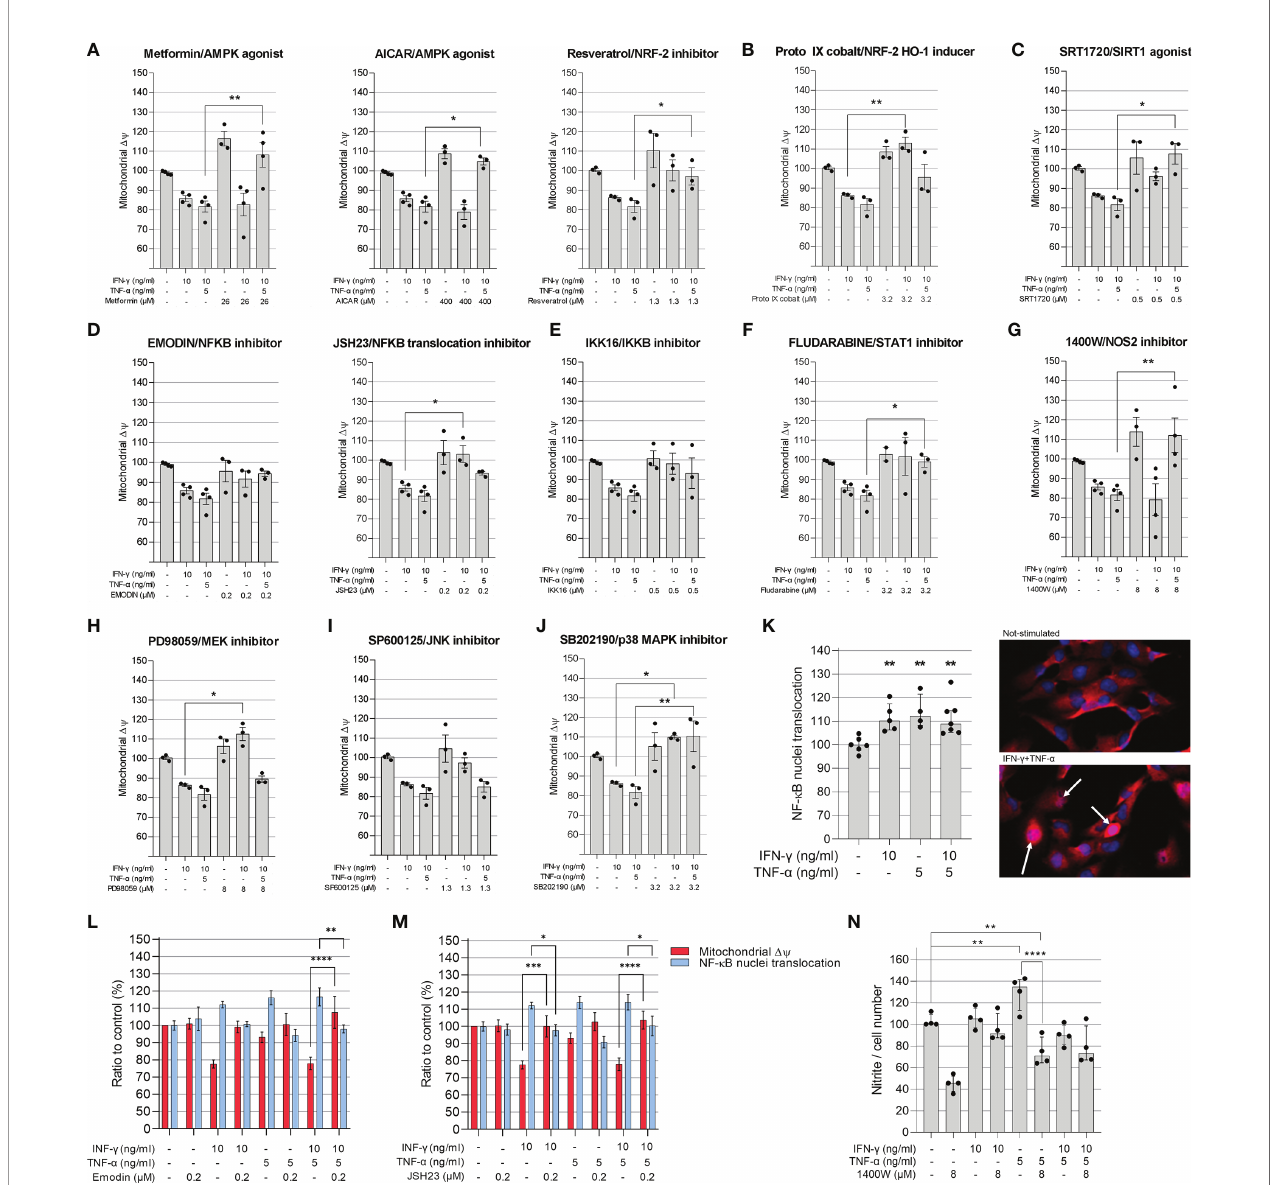
FIGURE 4 | Evaluation of compounds in the mitochondrial membrane potential of AC-16 cells. Selected doses of agonists of AMPK (A) , NRF2 (B) , SIRT1 (C) or inhibitors of NF- k B (D) , IKK b (E) , STAT1 (F) , NOS2 (G) , MEK1 and MEK2 (H) , JNK (I) and MAPK (J) were used alone or in combination with 10 ng/ml of IFN- g or IFN- g plus 5 ng/ml of TNF- a . Speci fi c doses were selected based on the highest effect on mitochondrial DY m and less than 10% loss on cell number. (K) The nuclear translocation of NF- k B in AC-16 cells was quanti fi ed by immunocytochemistry. Simultaneous measurement of DY m and NF- k B translocation of cells stimulated with 10 ng/ml of IFN- g or IFN- g plus 5 ng/ml of TNF- a in combination with the NF- k B inhibitors (L) emodin and (M) JSH23. Statistics shown only when both DY m and NF- k B translocation were signi fi cant. (N) the amount of nitrite (µM) in conditioned medium was measured by Griess reaction of cells stimulated with 10 ng/ml of IFN- g or IFN- g plus 5 ng/ml of TNF- a in combination with NOS2 inhibitor 1400W. Micrographs of NF- k B stains in the nucleus (white arrow). All data are shown as percentage to not-stimulated cells. Standard deviation is from ≥ 3 independent experiments. *p < 0.05; **p < 0.01; ****p < 0.0001 one-way Anova Dunn ’ s post